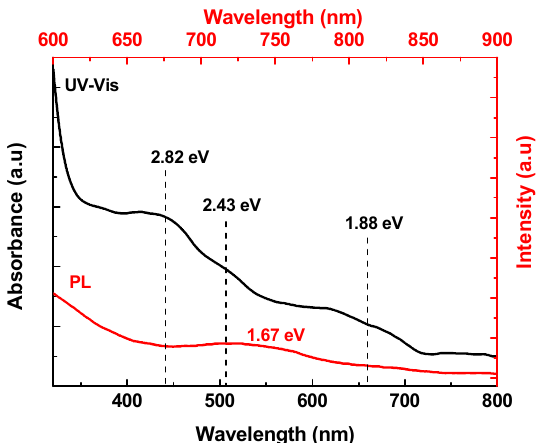
Figure 8. UV–Vis absorption (black line) and photoluminescence spectra (red line) of WS 2 nanoflowers.